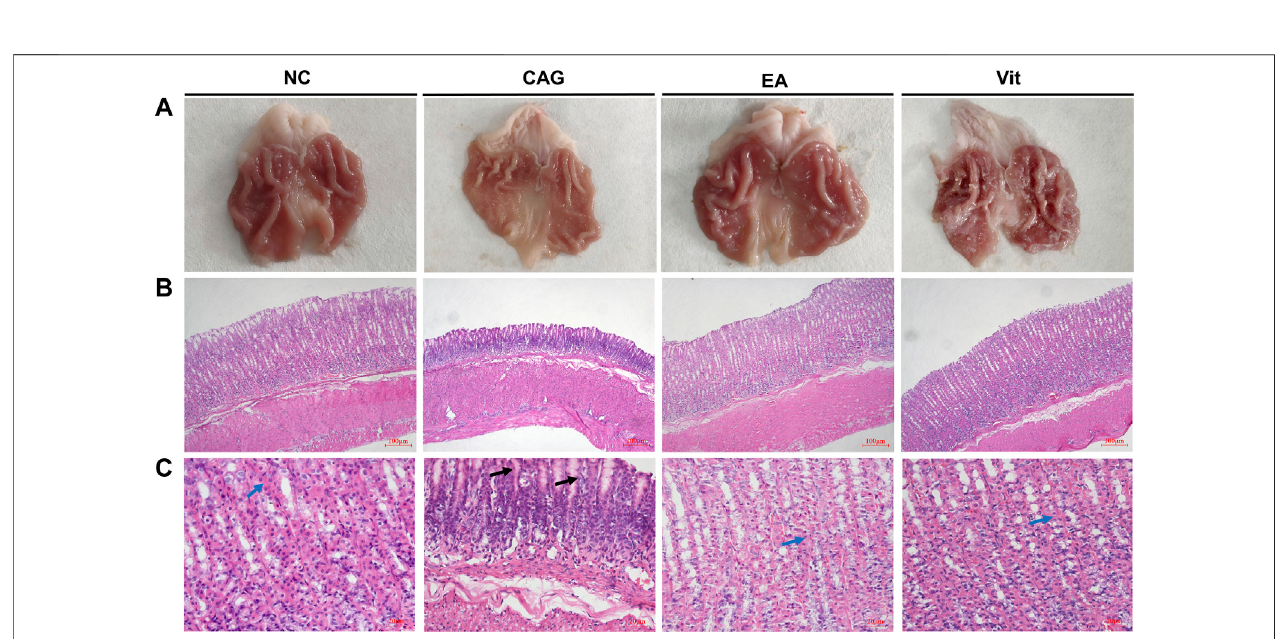
FIGURE 2 | Histomorphological observation of the gastric mucosa in each group of rats. (A) Observation of the gastric mucosa in each group of rats with naked eyes. (B) Observation of the gastric mucosa in each group under a fl uorescence microscope at 100×. (C) Observation of the gastric mucosa in each group under a fl uorescence microscope at 400×. Blue arrows show parietal cells, and black arrows show plasma cells and lymphocytes.